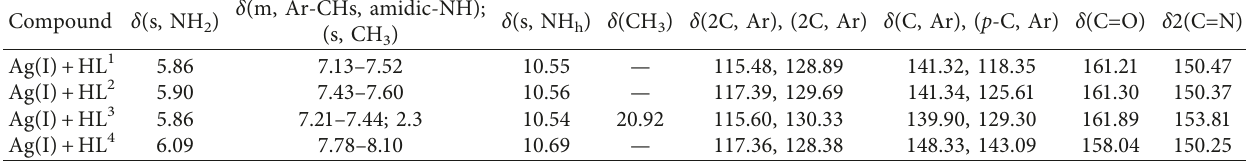
Table 2: DMSO- d 1 H NMR, and 13 C NMR data (ppm) for Ag(I)-pyrazolone complexes. 6 ,